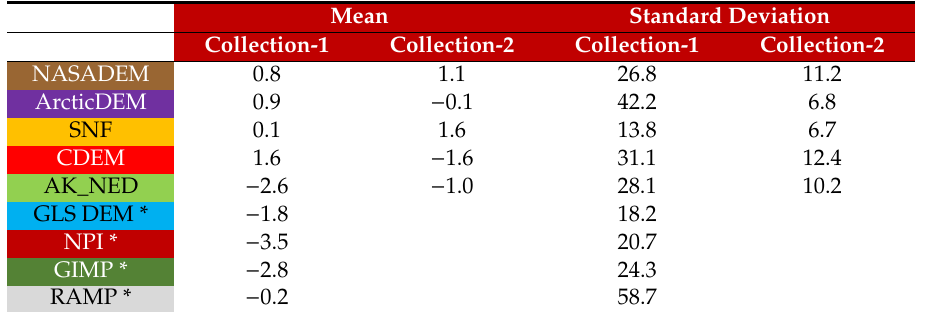
Table 9. Dataset comparisons against WorldDEM, in meters. Colored headings are to help in locating datasets, geographically, in Figure 1. datasets, geographically, in Figure 1.